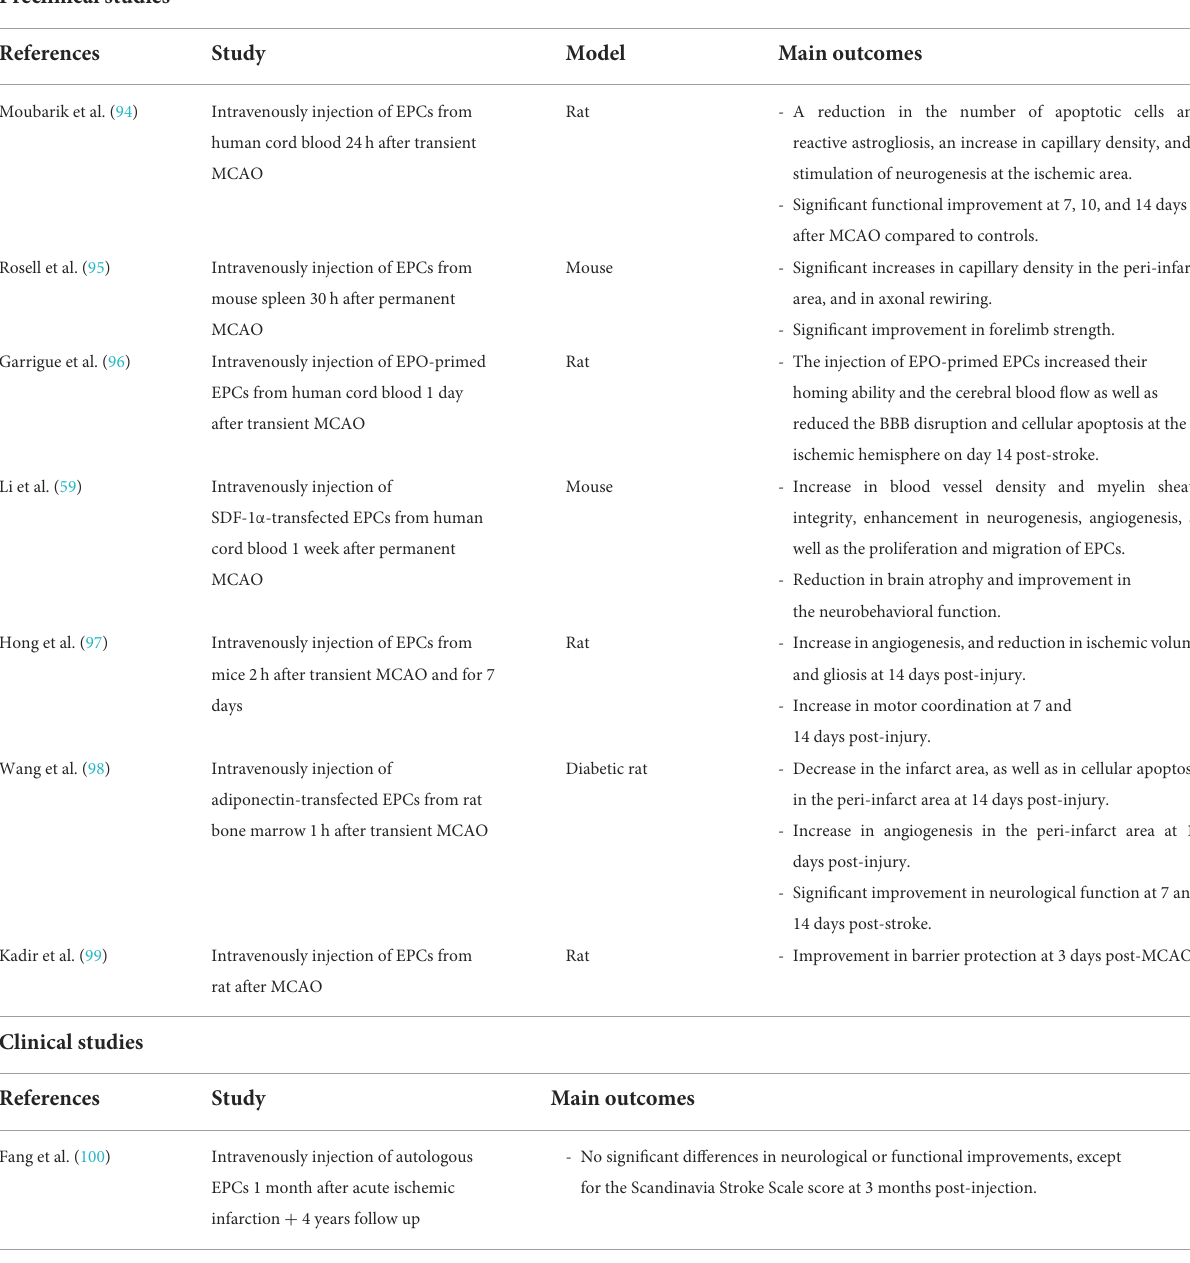
TABLE 1 Summary of relevant preclinical and clinical studies targeting EPCs following